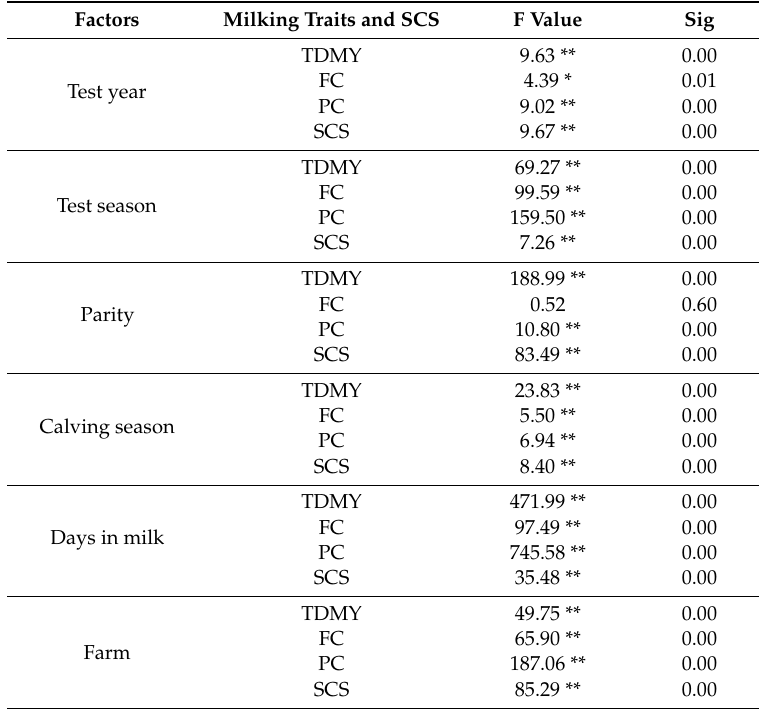
Table 4. E ff ects of di ff erent non-genetical factors on milking traits and somatic cell score (SCS) of Holstein